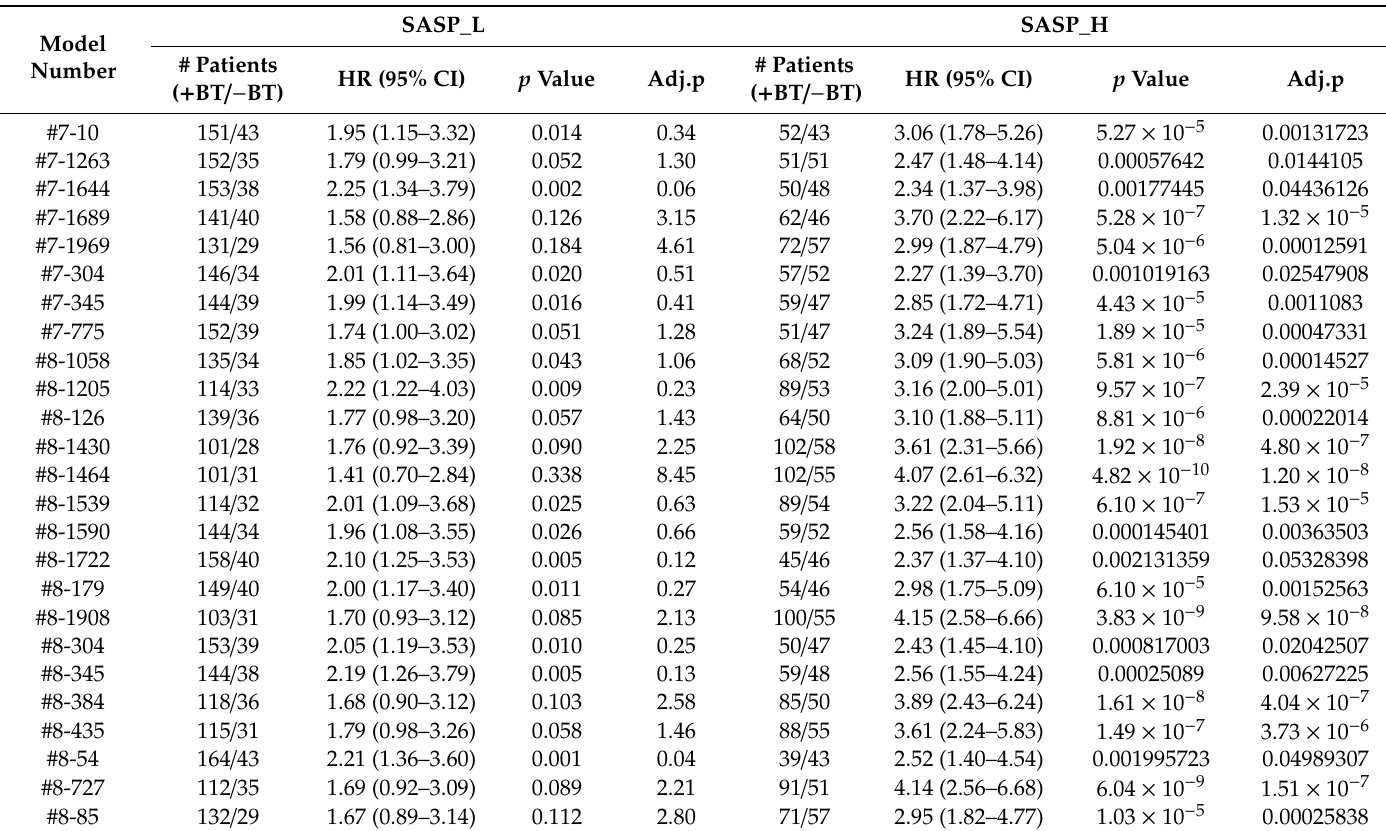
Table 5. Impact of SASP status on response to